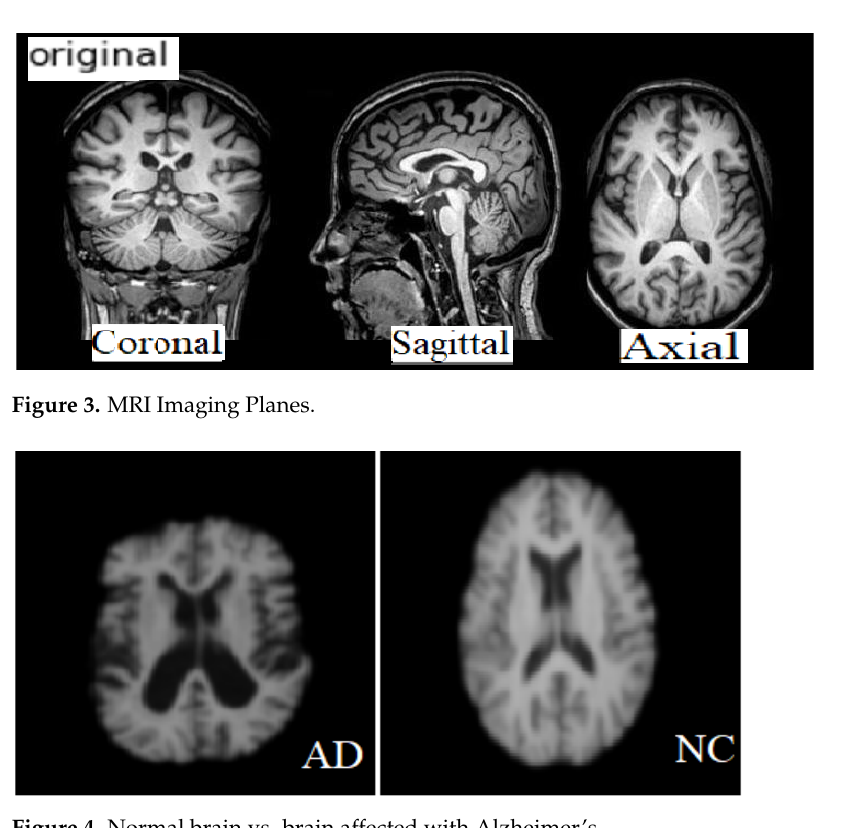
Figure 4. Normal brain vs. brain affected with Alzheimer’s.